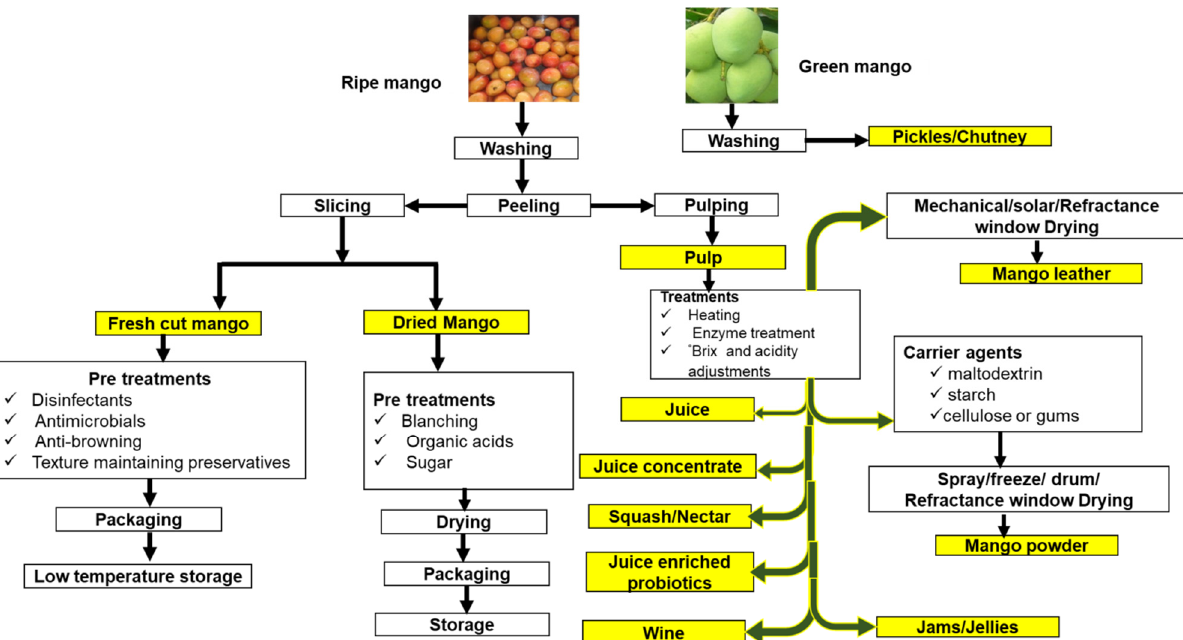
Figure 1. Processing of different products derived from mango. (Modified from